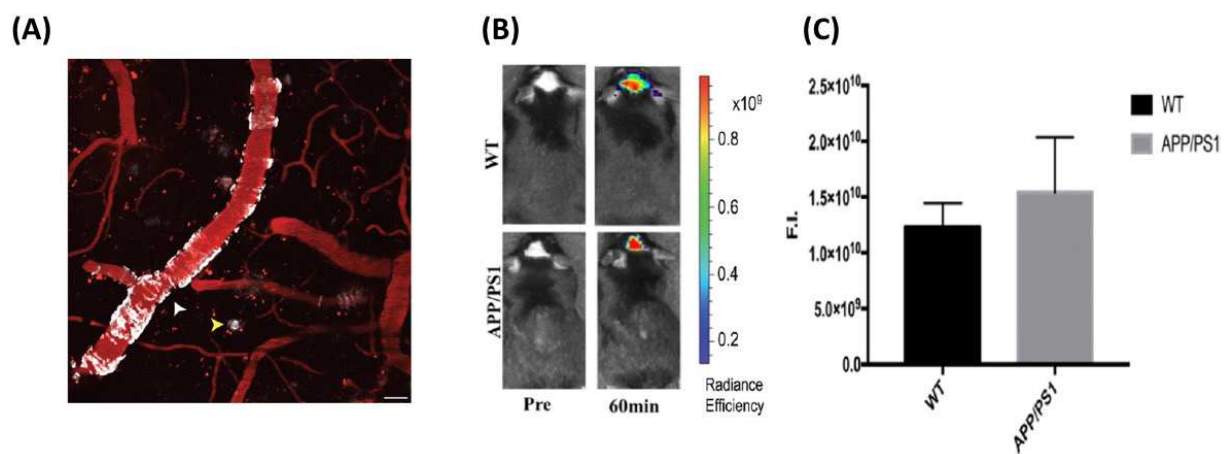
Figure 6. ( A ) Two-photon images of CRANAD-28 labeling in a 9-month-old APP/PS1 mouse. Both CAA and amyloid plaques were labeled (white arrow). ( B ) Representative images of APP/PS1 and WT mice after i.v. injection with AD-1 at 60 min; ( C ) Fluorescence intensity of the brain in APP/PS1 and WT mice at 60 min. Reprinted with permission from [60] . Copyright 2021 American Chemical Society.